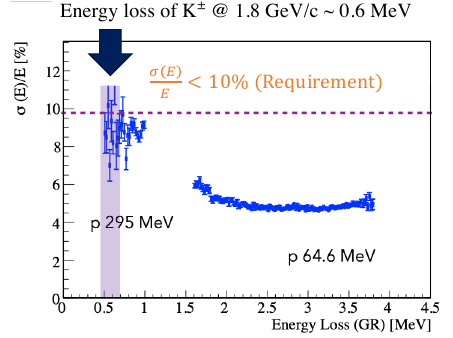
Fig. 3. Obtained energy resolution of detector (AFT-proto1) as a function of the energy loss which was measured by Grand Raiden at RCNP.